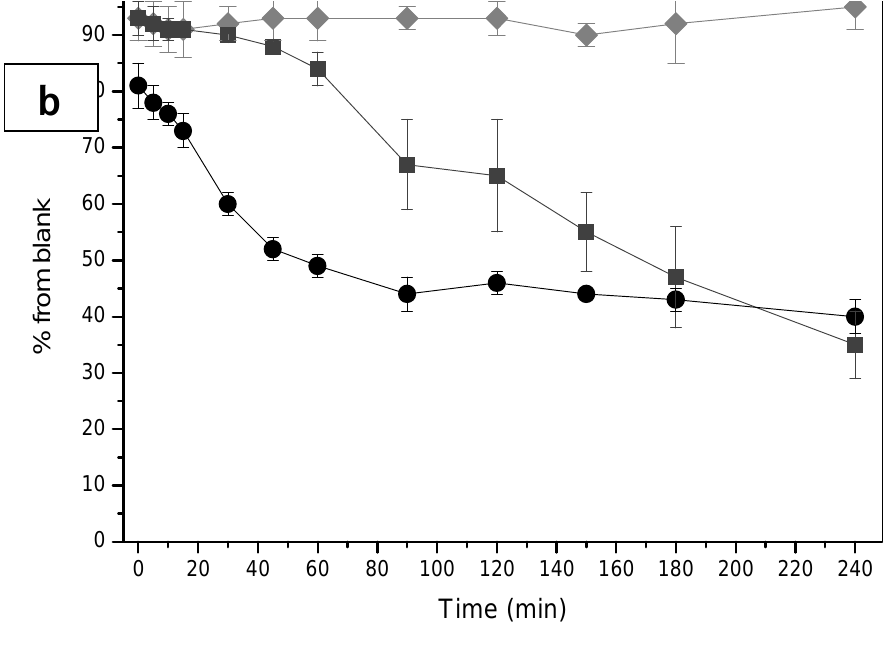
Figure 1b. Bioluminescence response to rapamycin in real-time monitoring during an exposure of 4h. Rapamycin reveals totally different bioluminescence response. The error bars are shown for triplicate parallel measurements and the symbols are diamonds (0.05 µM), Squares (0.5 µM), and circles (5 µM) denote for concentration of rapamycin used,